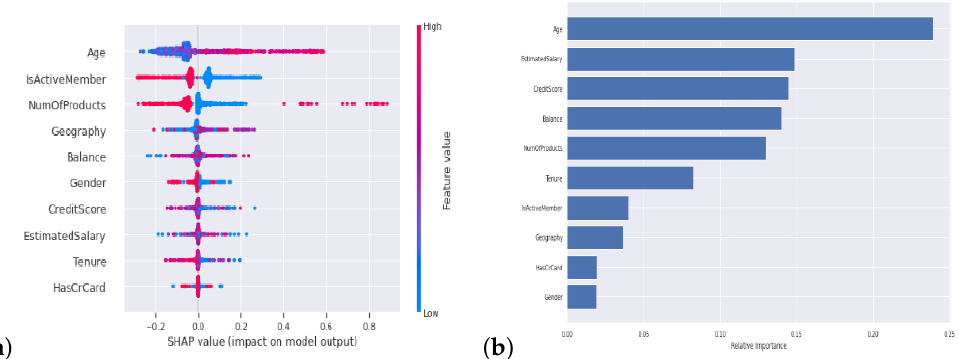
Figure 8. Visualizing the model explanation with the plotting of ( a ) shap values and ( b ) features